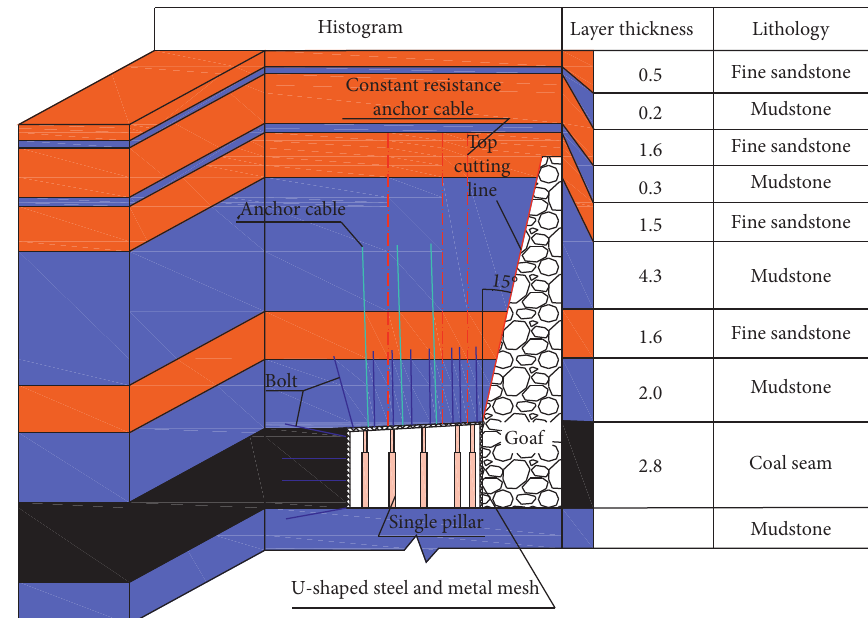
Figure 12: Diagram of the roadway section